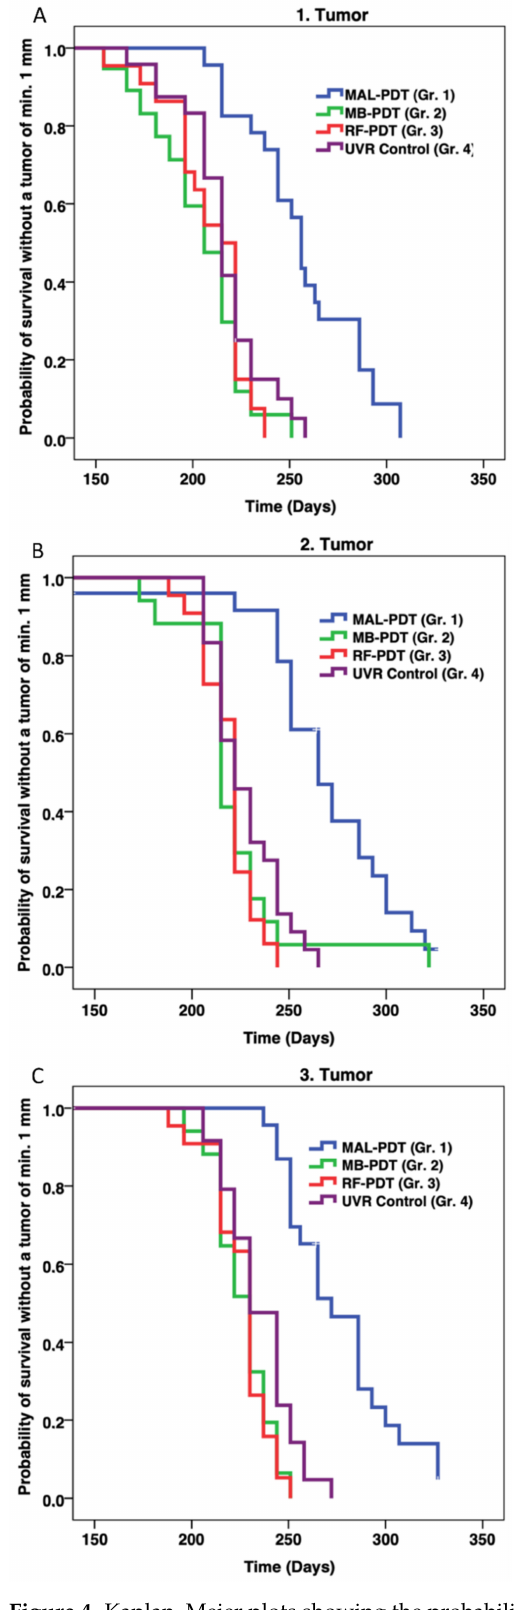
Figure 4. Kaplan–Meier plots showing the probability of survival without a first ( A ), second ( B ), and third ( C ) tumor (minimum diameter = 1 mm) as a function of time. Abbreviations: MAL, methyl aminolevulinate; MB, methylene blue; RBF, riboflavin; Gr.,